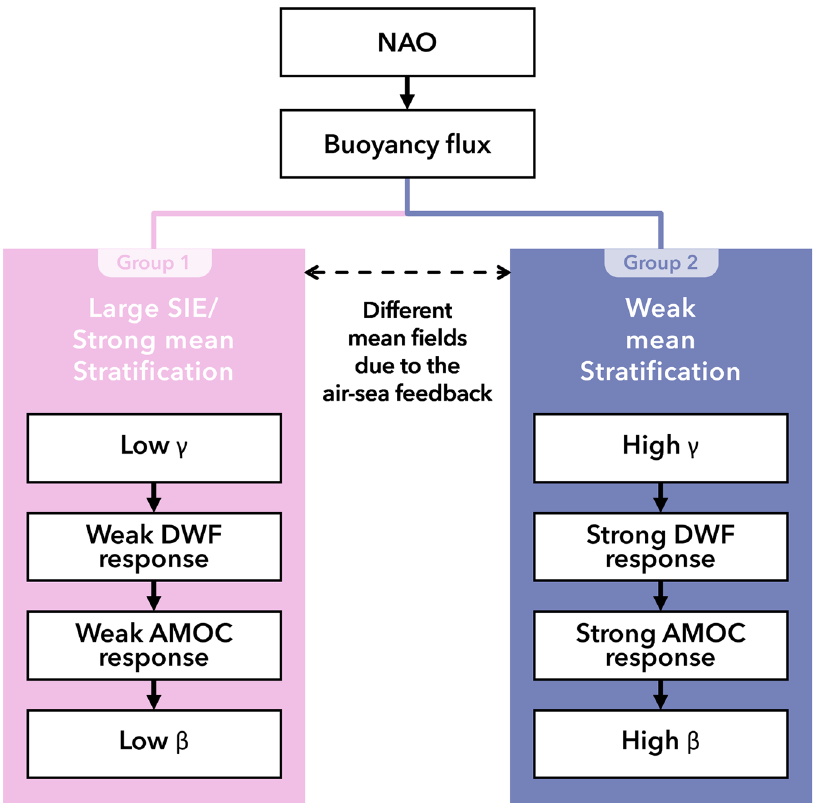
Fig. 5 Schematic representation of NAO in fl uence on the AMOC for each group. This schematic illustrates why coupled climate models simulate different sensitivities of the AMOC to the NAO ( β ). Colored box indicates a group of models that share the similar background states; pink for Group 1 and blue for Group 2. ‘ SIE ’ means sea ice extent and ‘ DWF ’ represents deep water formation. See Text for more detailed